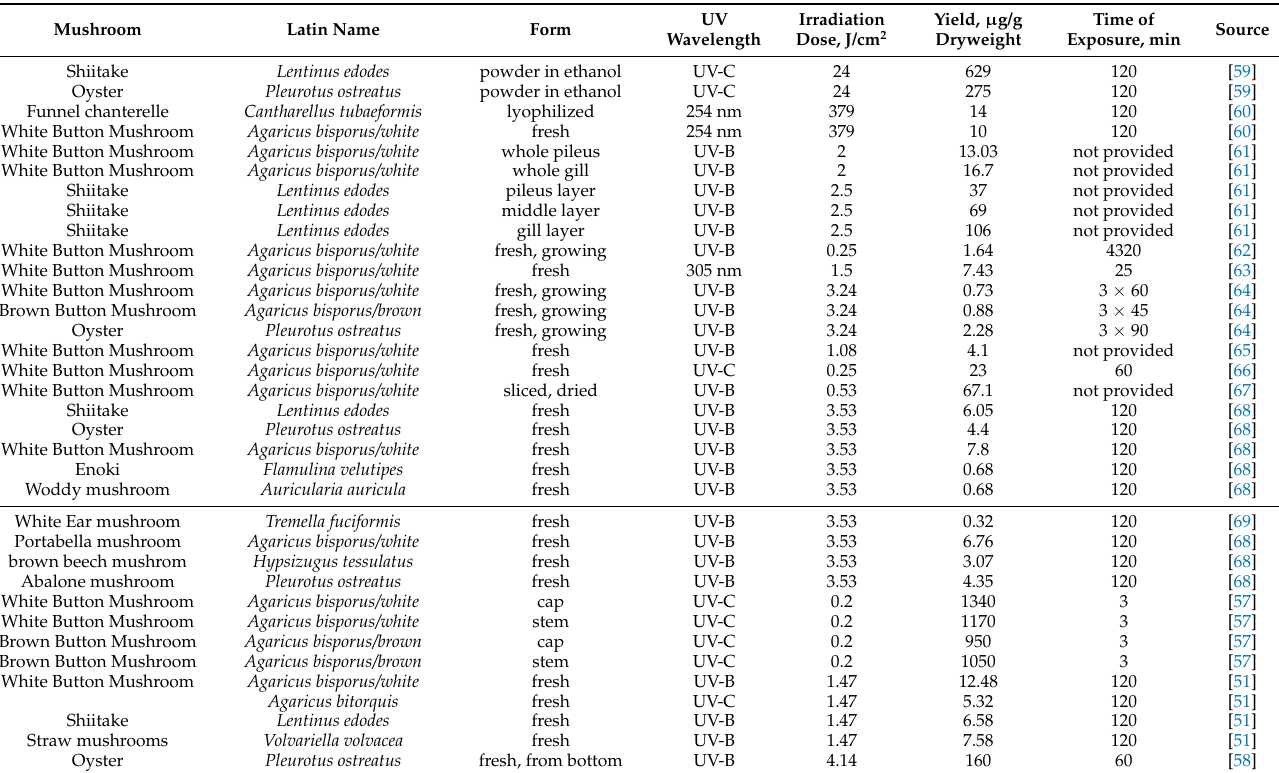
Table 2. Overview of vitamin D 2 yields after UV irradiation, utilising different mushrooms, provided forms, wavelengths, and light intensities. Vitamin D 2 contents marked with a star refer to the fresh, undried state.